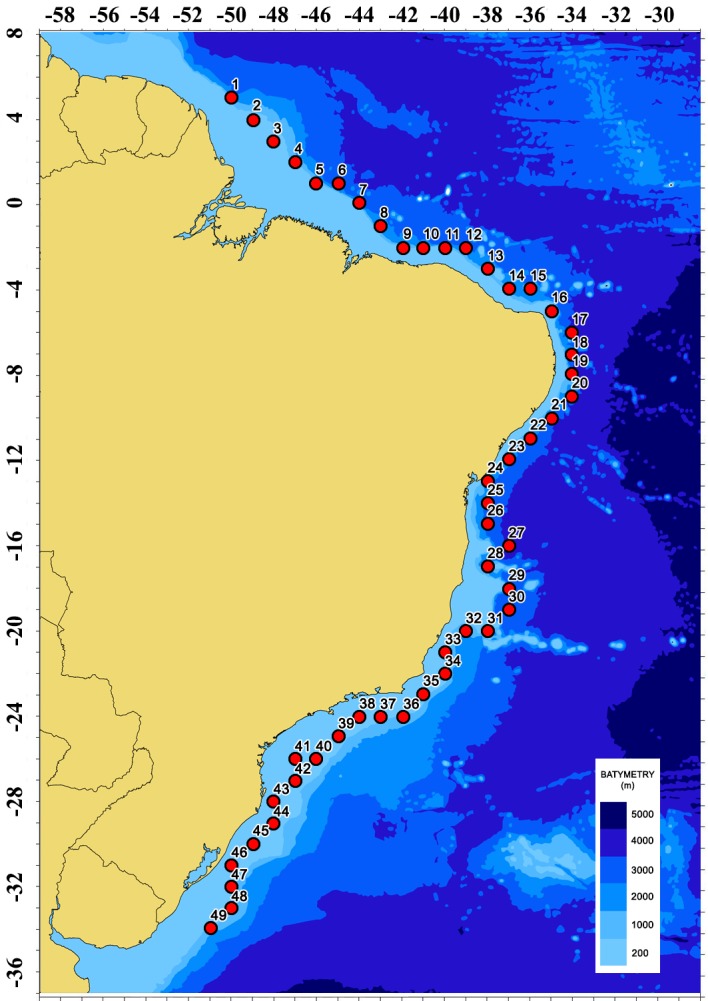
Bathymetry of the Brazilian Coast.Bathymetry source [18].